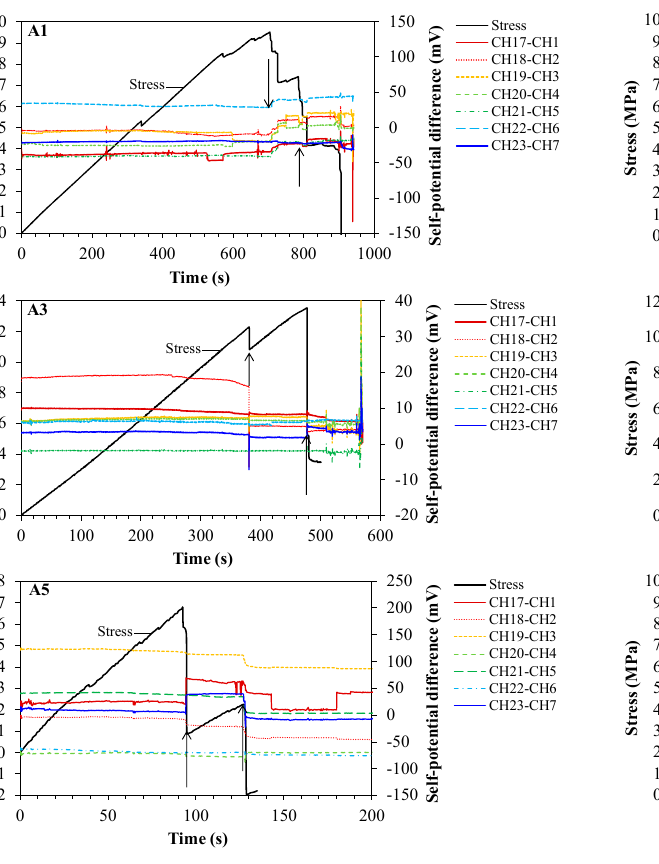
Figure 5. Curves of stress and axial self-potential difference with time of bituminous coal samples A1 to A6 under uniaxial loading.